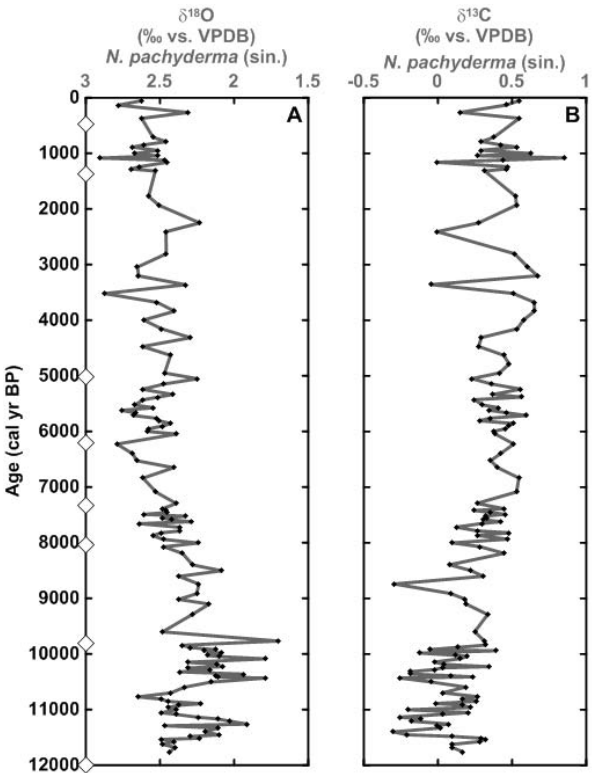
Fig. 5. Stable isotope analysis plotted versus calyrBP. The white diamonds on the y axis denote the AMS 14 C converted to calibrated radiocarbon ages. (A) δ 18 O measurements of N. pachyderma (sin.) corrected for ice volume effect after Fairbanks (1989). (B) δ 13 C measurements of N. pachyderma